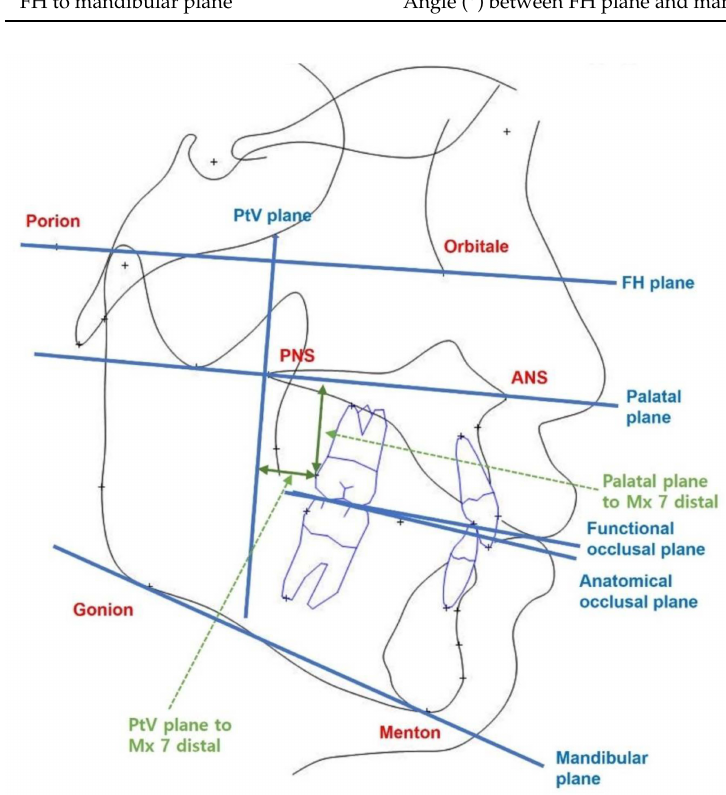
Figure 5. Definitions of cephalometric reference planes and